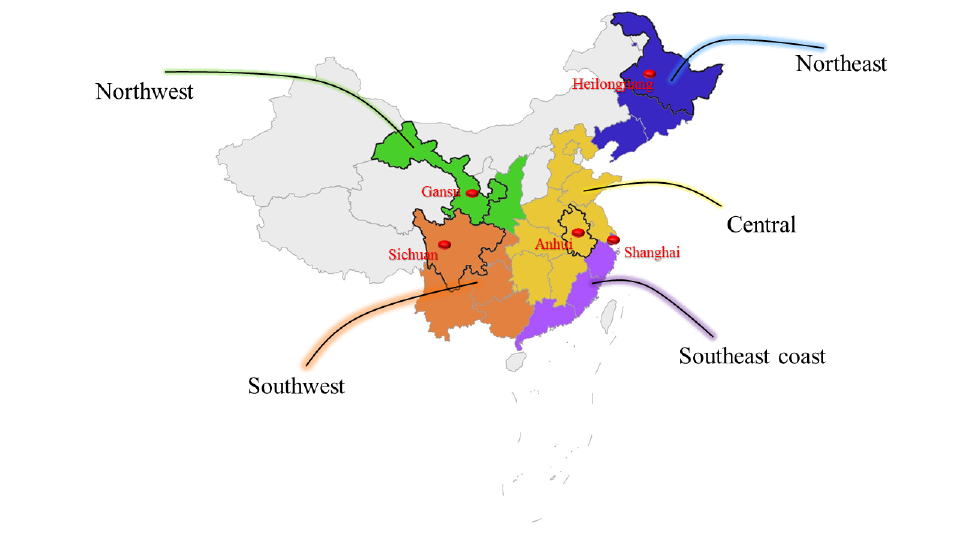
Figure 4. Classified provinces based on geographical status and economic conditions. Then select five typical provinces.